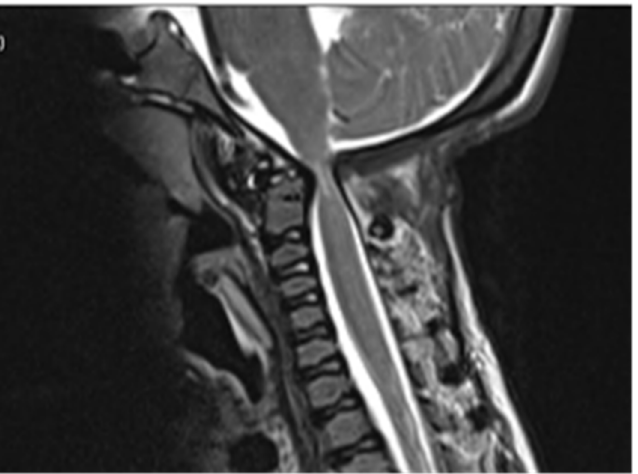
Figure 3. Preoperative MRI scanning of cranio-cervical junction revealed critical stenosis and myelopathy, 14 years of age.